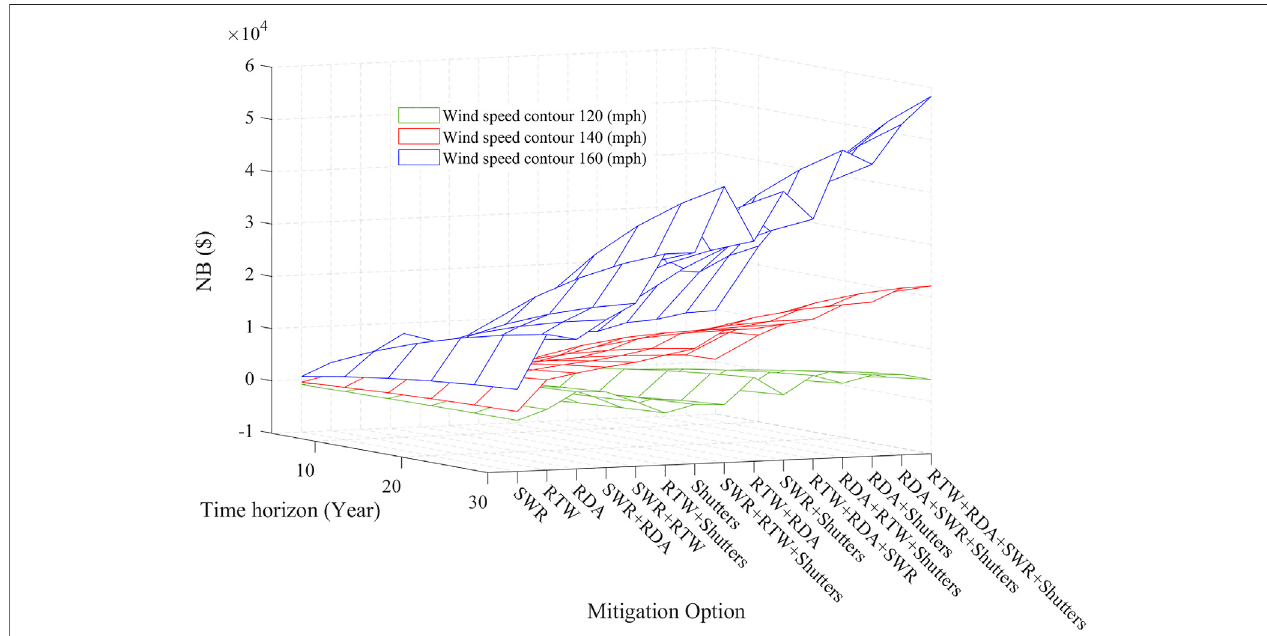
FIGURE 6 | Net bene fi t for wind contour 120, 140, and 160 as a function of homeowner time horizon and mitigation option.